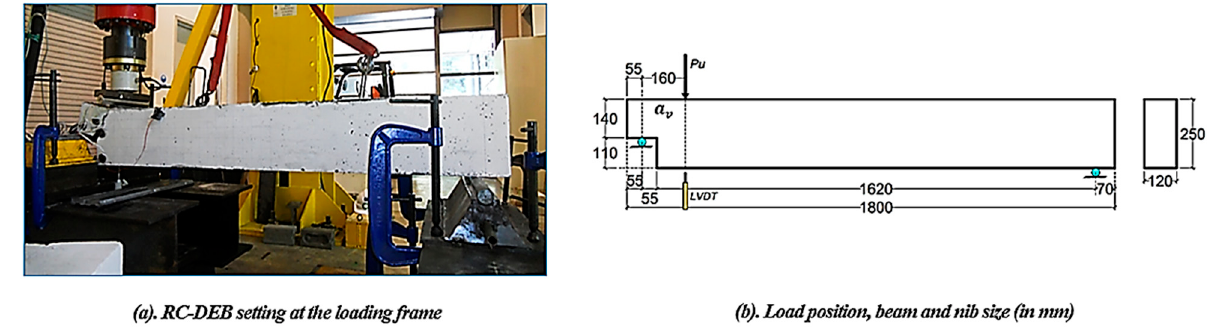
Figure 2. Experimental setup of RC-DEBs under three-point bending static test. Four rosette strain gages (RSGs) with three directions (a, b, and c) were attached at different locations at the dapped-end region in order to measure the strain at various locations, as shown in Figure 3. All RSGs were also connected to the data logger. The rosette strain reading was taken up to 80% of the maximum applied load in order to avoid missing any data due to the damage of RSG [43]. Besides, the stress concentration factor (SCF) was evaluated based on the relevant stresses obtained from the measured strains. The